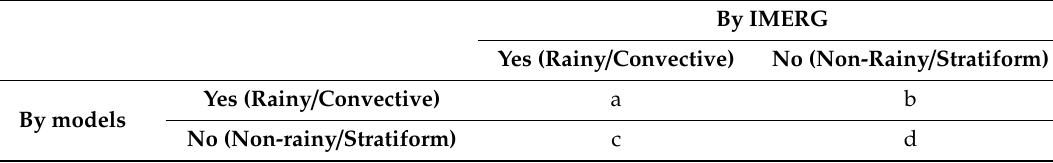
Table 4. Contingency parameters of the statistical